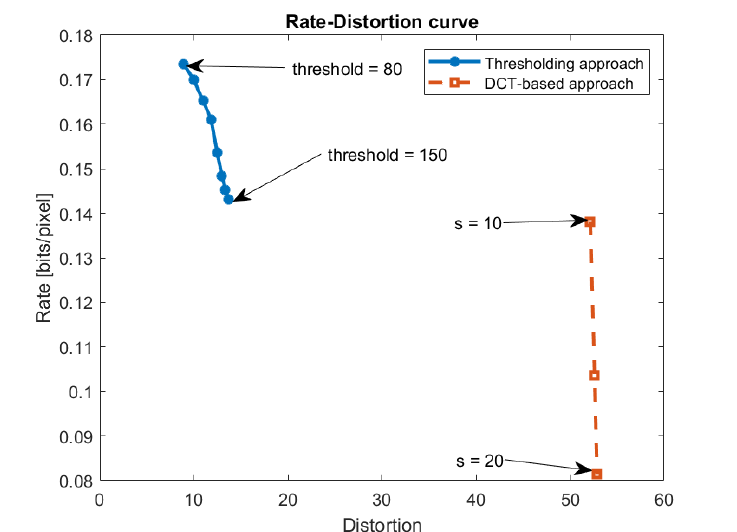
Figure 7. Rate-distortion curves for both